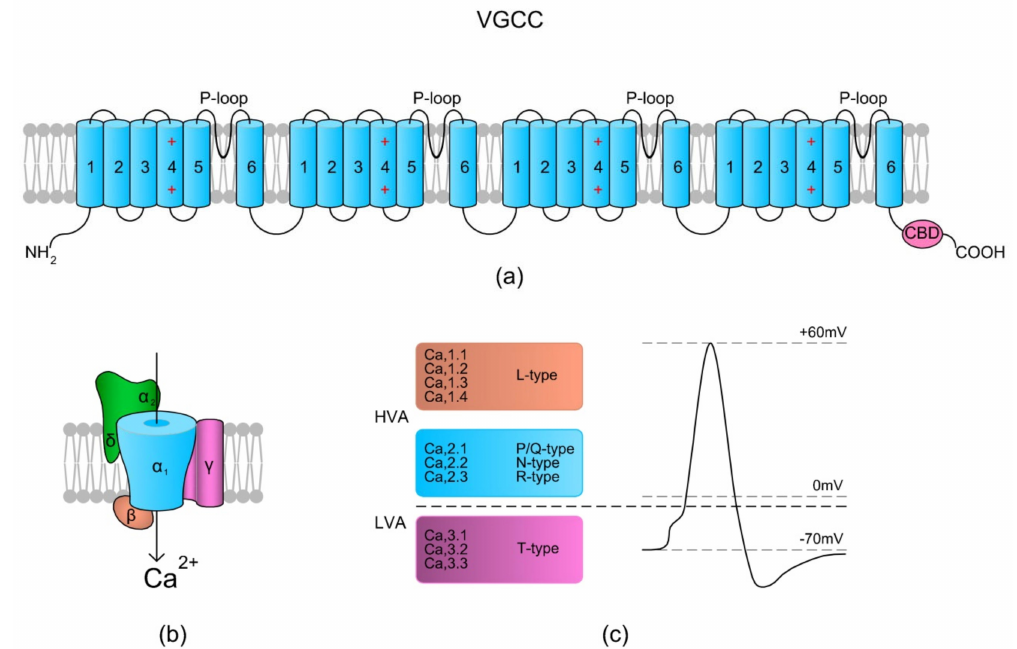
Figure 1. Voltage-gated Ca 2+ channel (VGCC) structure scheme. ( a ) The topology of the α 1 subunit is made up of four homologous domains that each consist of six transmembrane α helices (TM1–6). TM4 from each homologous domain serves as the voltage sensor moving outward and rotates under the influence of the electric field, thereby initiating a conformational change that opens the respective pore. TM5, TM6, and the loop between them (P-loop) from each domain form a pore. The C-terminal tail contains a Ca 2+ binding domain (CBD) and in some types of VGCCs a site for calmodulin (calcium-modulated protein; CaM) binding. The binding of Ca 2+ to CBD or via CaM inactivates the channels. ( b ) A schematic presentation of the VGCC subunits ( α 1, α 2 δ , β , and γ ) with their spatial localizations. ( c ) Overview of the types of VGCCs in relation to Vm-dependent activation – high voltage activation (HVA) and low voltage activation (LVA) (based on References